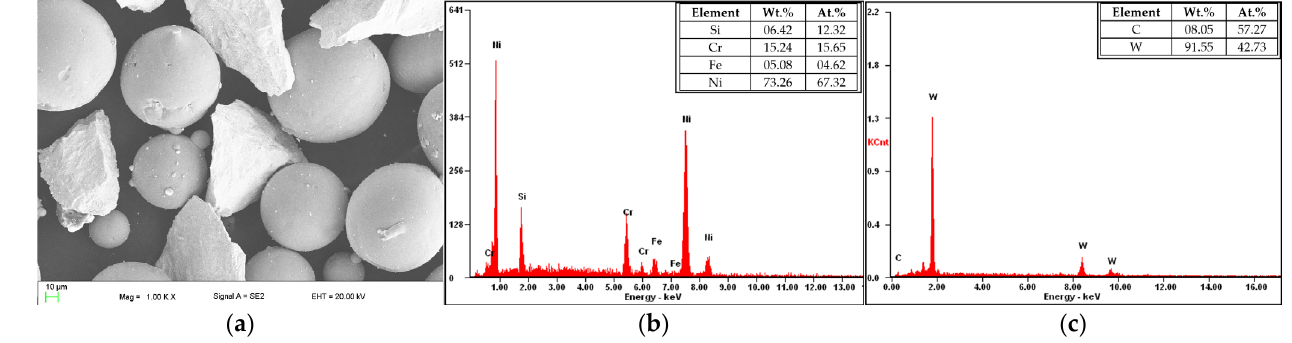
Figure 4. ( a ) SEM image of the analysed particles of the composite powder (Table 1); ( b ) EDS spectra of the spherical particle of matrix component, and ( c ) EDS spectra of the irregular WC particle.